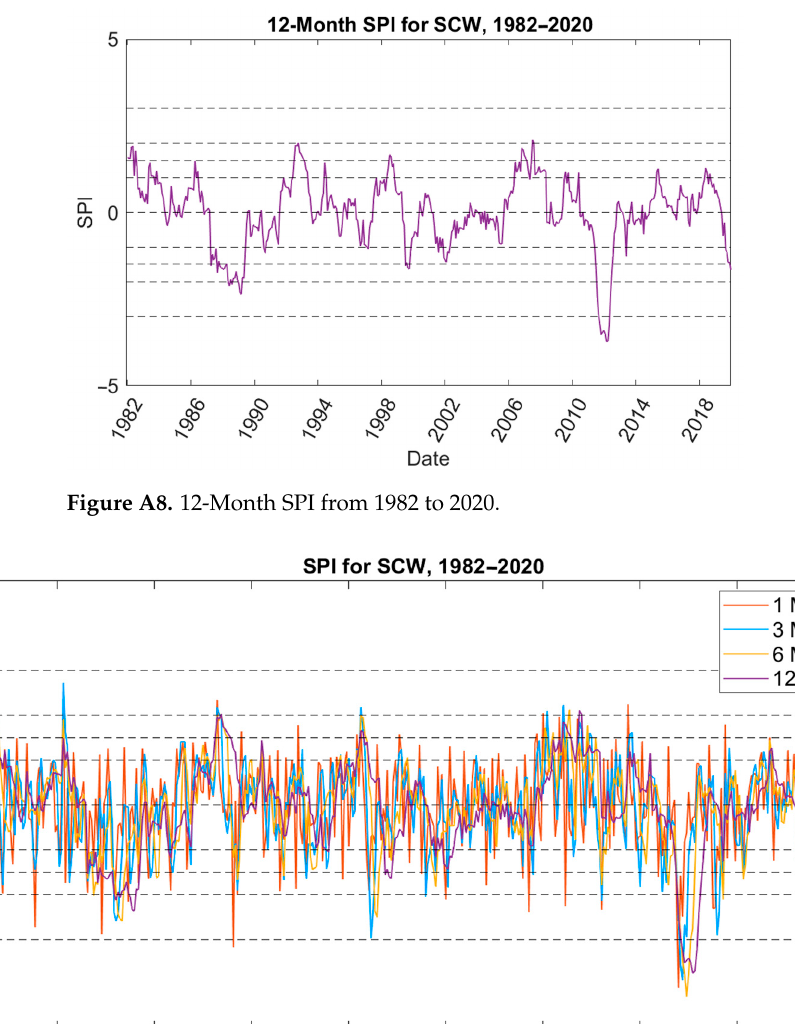
Figure A9. 1 ‐ , 3 ‐ , 6 ‐ , and 12 ‐ Month SPI from 1982 to 2020 plotted on the same axes.